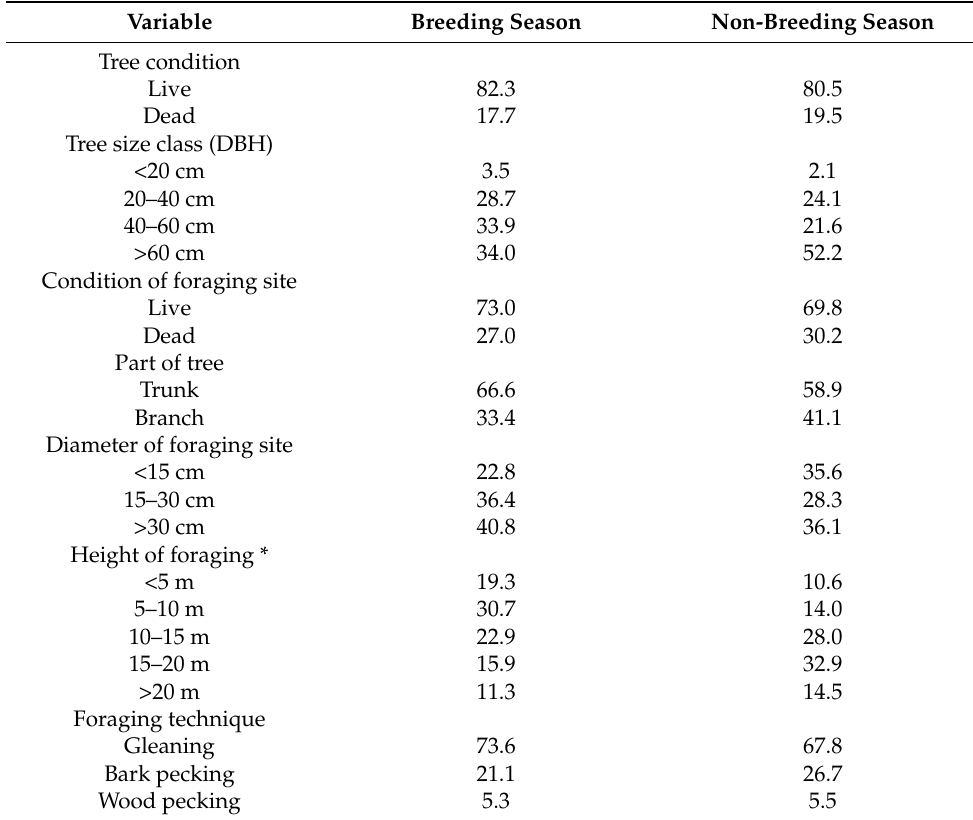
Table 2. Percentage distribution of foraging time of the Middle Spotted Woodpecker in relation to tree condition, DBH, condition of the site used, part of a tree, diameter of the part used, foraging height and foraging technique. Asterisk shows the parameter that differs between the breeding and non-breeding